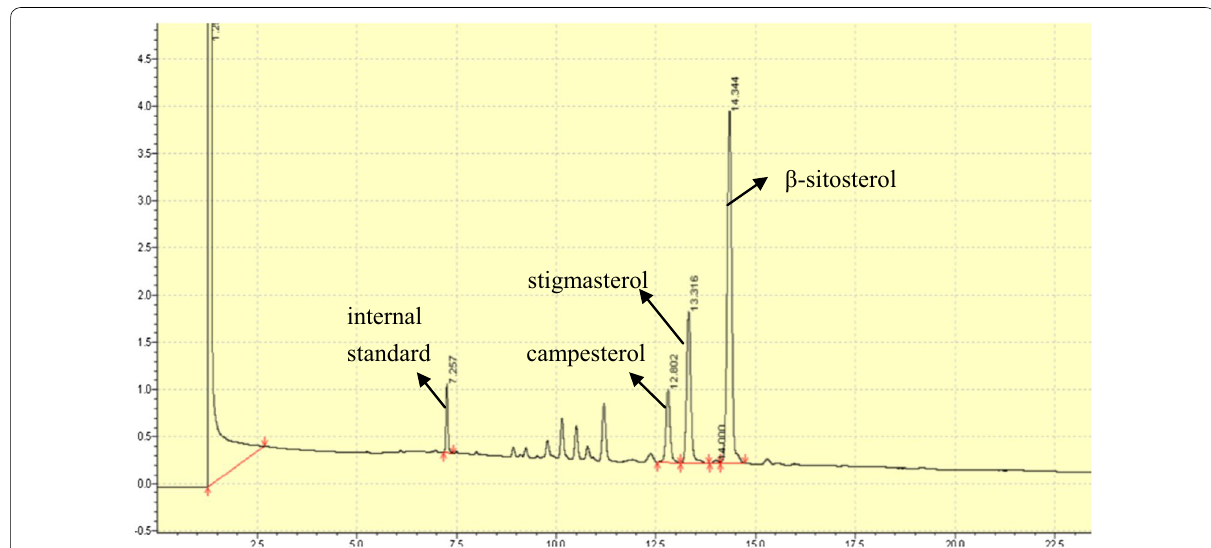
Fig. 8 Gas chromatogram of phytosterols. All authors have the responsibility to obtain permission from the copyright holder to reproduce figures or tables that have previously been published elsewhere